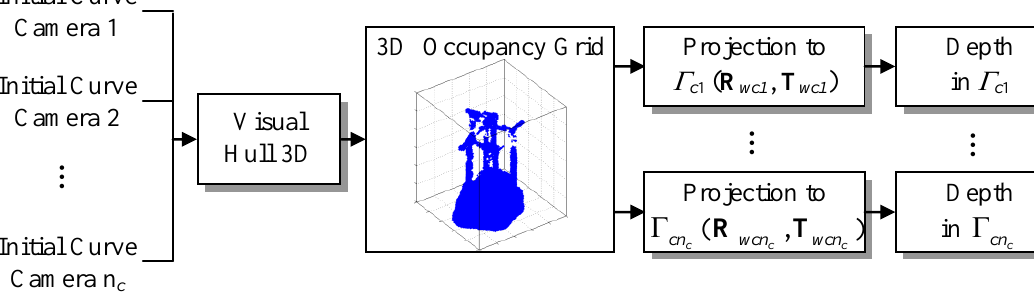
Figure 6. General block diagram of the proposed method for curve initialization using